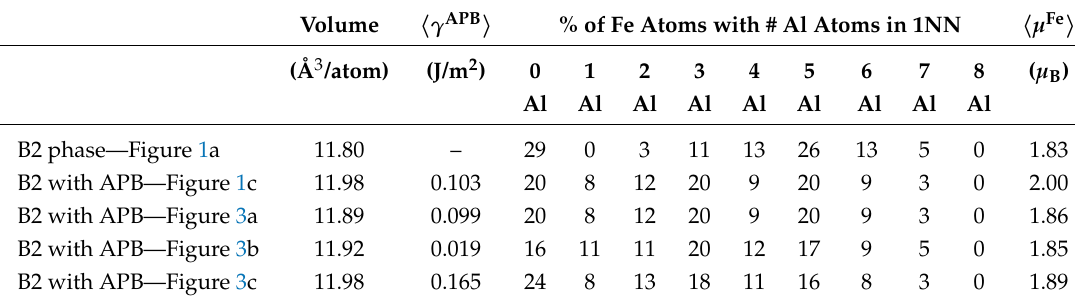
Table 1. Computed properties of the studied atomic configurations including the B2 phase without APBs as well as variants of APB-containing B2 phase. The table summarizes volumes, APB energies in the case of APB-containing configurations, percentages of Fe atoms with different number of Al atoms (from 0 to 8) in the 1NN shell and the average value of magnetic moments of Fe atoms (cid:104) µ Fe (cid:105)